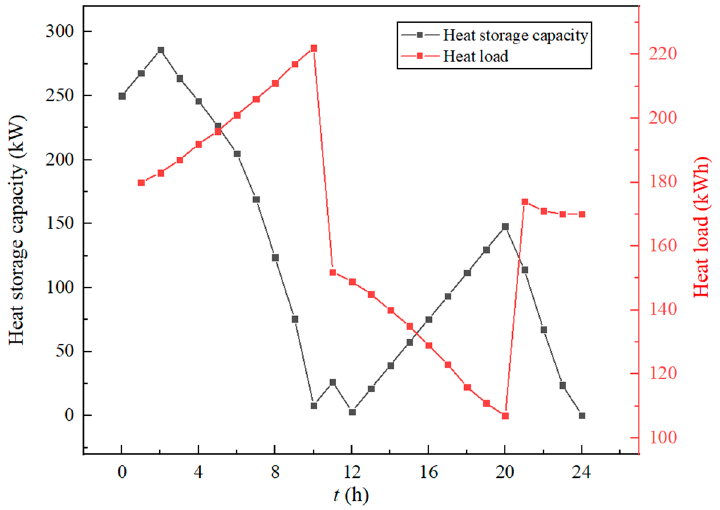
Figure 7. Heat storage capacity and heating load in each period when the objective function is op- erating costs.